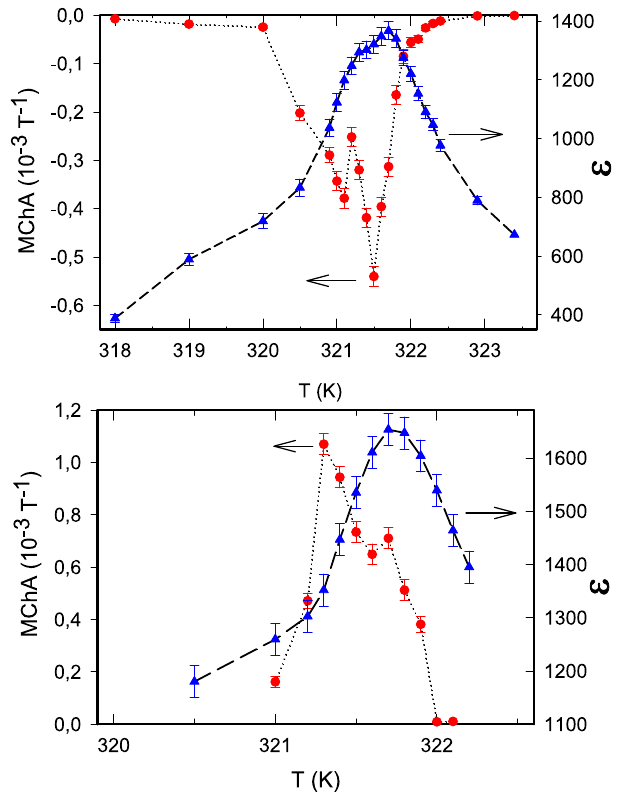
Fig. 2 Chirality and temperature dependence. Temperature dependence of the dielectric constant (blue triangles) and the magnetochiral anistropy (MChA, red balls) of TGS samples. Top panel: + poled, bottom panel − poled. Electric fi eld 10 kV/m, frequency 50 kHz, B = 2 T. Lines are guides to the eye.